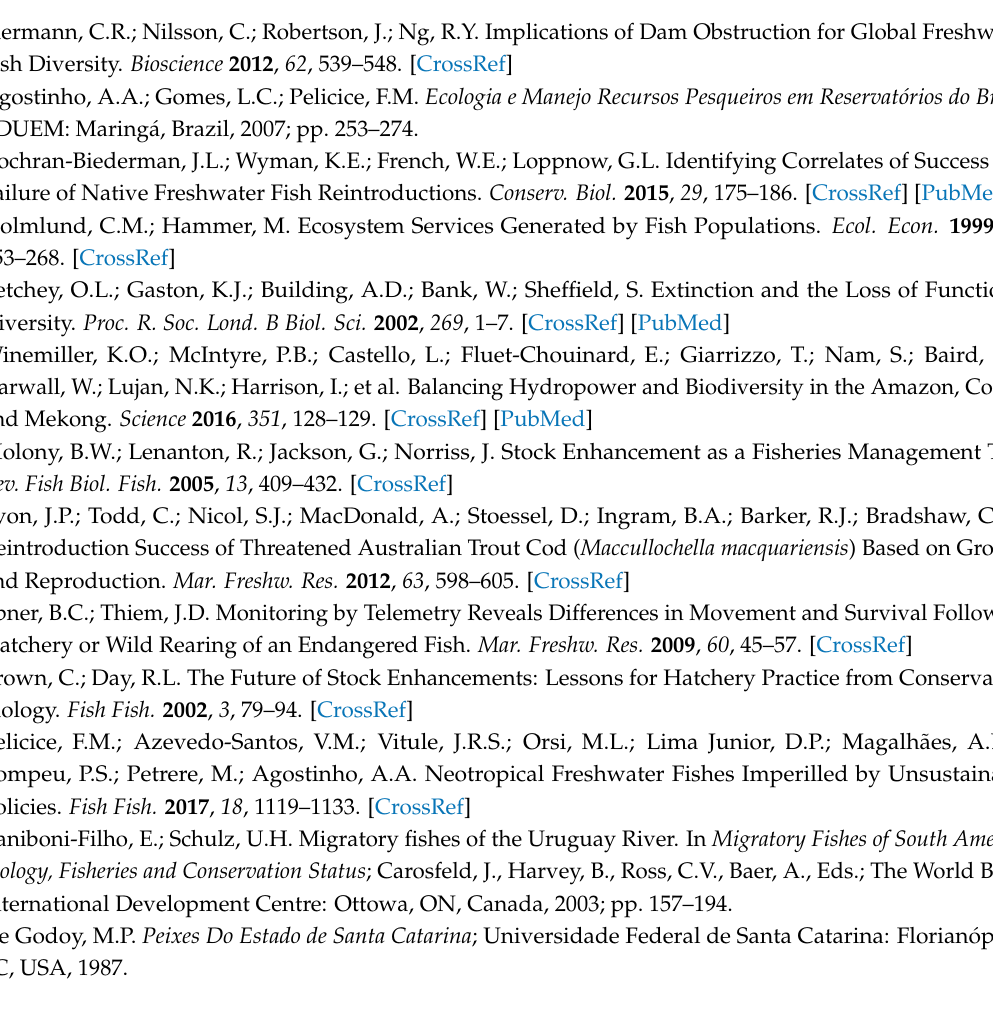
Table S1: Details of the recaptured fish, Table S2: Characteristics of the amplified microsatellite loci, Table S3. Intra-population genetic diversity indexes obtained for two groups of Brycon orbignyanus . Average values based on 5 microsatellite loci, Table S4. Analysis of Molecular Variance (AMOVA) for recaptured and captive Brycon orbignyanus based on microsatellite